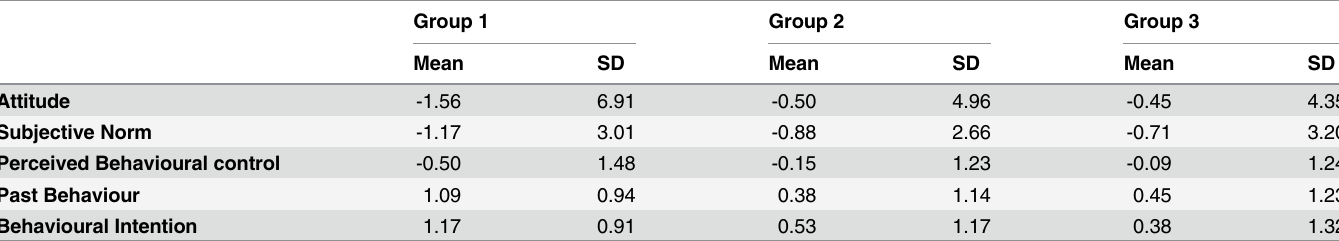
Table 1. Means and SD of components of the TPB.